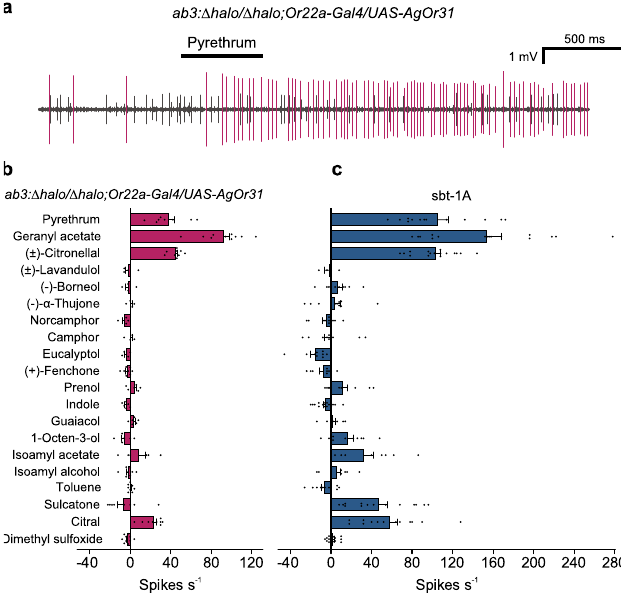
Fig. 3 Identi fi cation of pyrethrum-responsive AgOr31 from An. gambiae . a A representative single sensillum recording (SSR) trace ( n = 8 sensilla) from Drosophila ab3A empty neurons expressing AgOr31 to pyrethrum (10 − 2 v v − 1 ). An. gambiae AgOrs were expressed heterologously in the empty neuron (i.e., the ab3A neuron of the ab3 sensilla) in D. melanogaster . b Odorant response pro fi les from AgOr31 ( n = 4 sensilla). c Odorant response pro fi les from sbt-1A neuron in Ae. aegypti ( n = 16 sensilla/ mosquitoes). Data are plotted as mean ± s.e.m. and dots denote the value of each